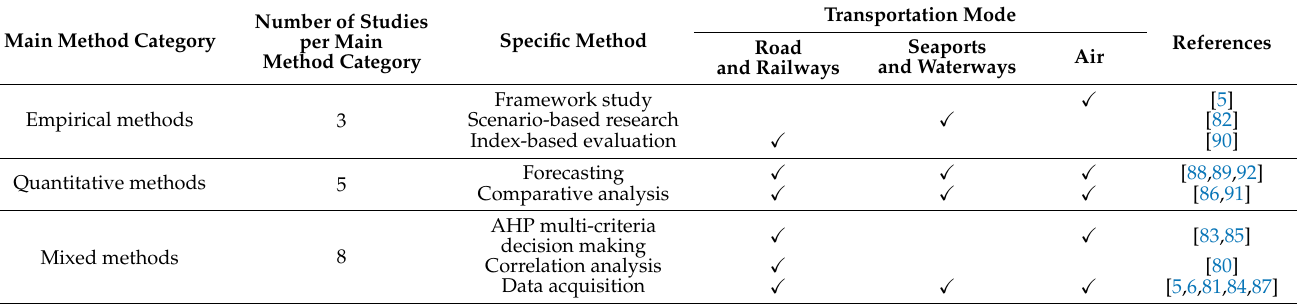
Table 11. Classification of research methods based on the transportation